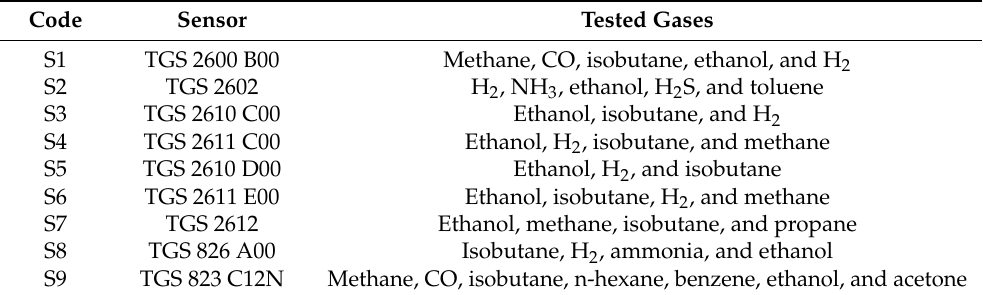
Figure 1. Schematic of the Enose built (in cleaning mode, when in valve V1, the flask was removed). Table 2. List of MOS Figaro gas sensors used in the Enose sensor array device; SnO 2 was used as the basis of the sensing